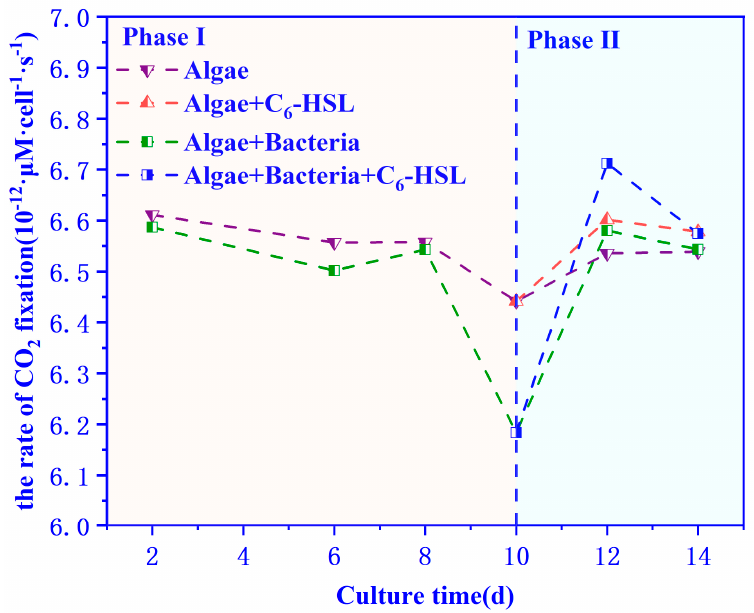
Figure 9. Effect of 10 ng/LC 6 -HSL on carbon fixation rates of algae group and algae–bacteria group. Algae+C 6 -HSL and algae+bacteria+C 6 -HSL are algae group and algae–bacteria group treated with C 6 -HSL, respectively.